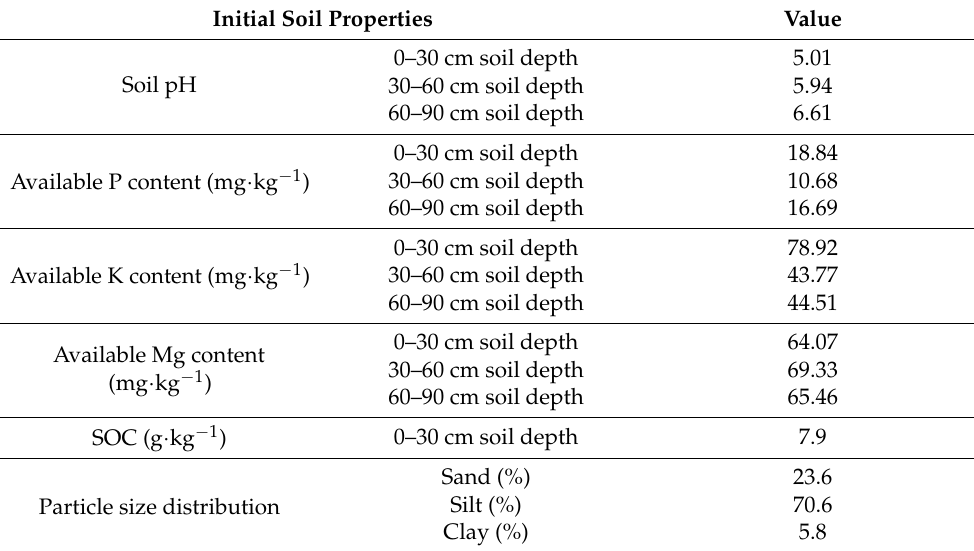
Table 1. Properties of the initial soil of the experiment site at Rog ó w, in 2014. Initial Soil Properties Value Soil pH